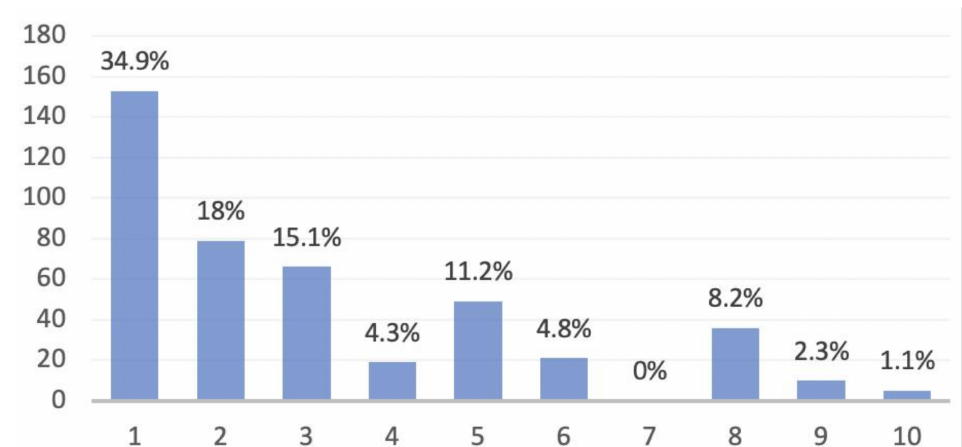
Figure 2. Distribution of the ten groups of diagnoses in 2020 knee medical records. (1) Post- surgery follow-up. (2) Degenerative disease. (3) Meniscus pathology. (4) Ligamentous pathology. (5) Patellofemoral disorders. (6) Osteocartilage pathology. (7) Growth pathology. (8) Traumatic injuries. (9) Other causes. (10) Unknown causes.